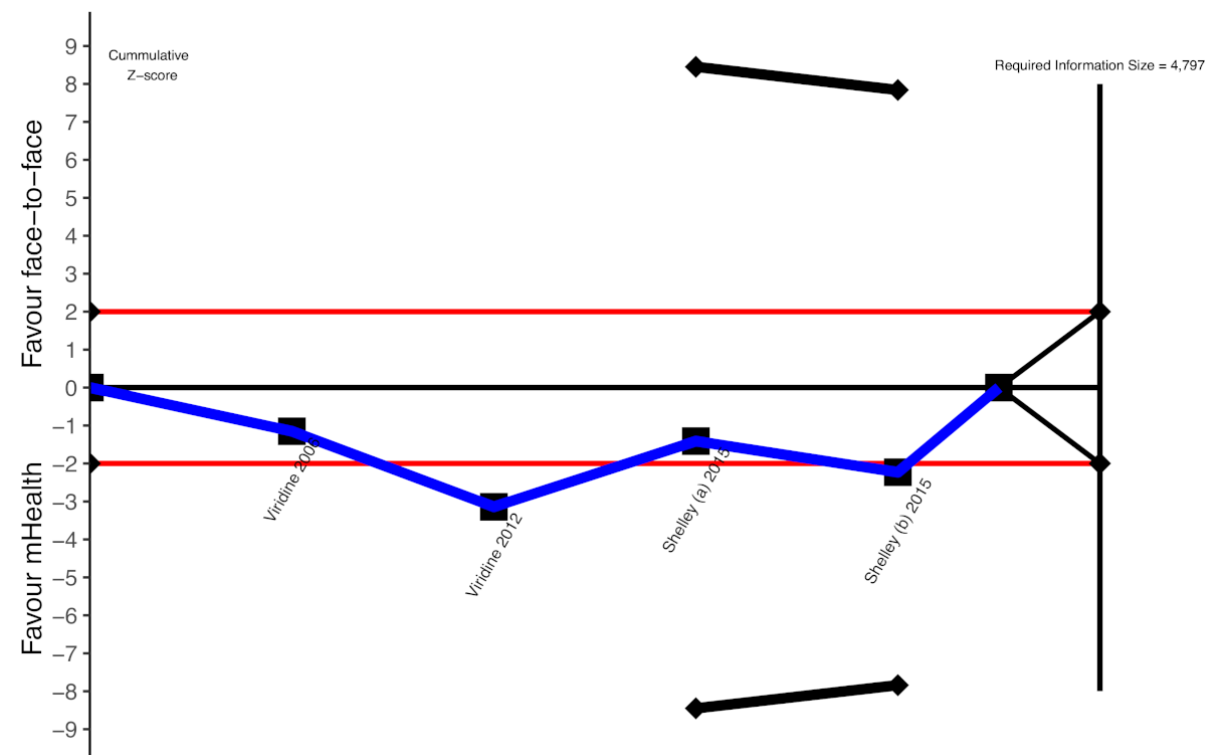
Figure 6. Trial sequential analysis for mHealth for smoking cessation in people living with HIV, short-term effect. mHealth: mobile